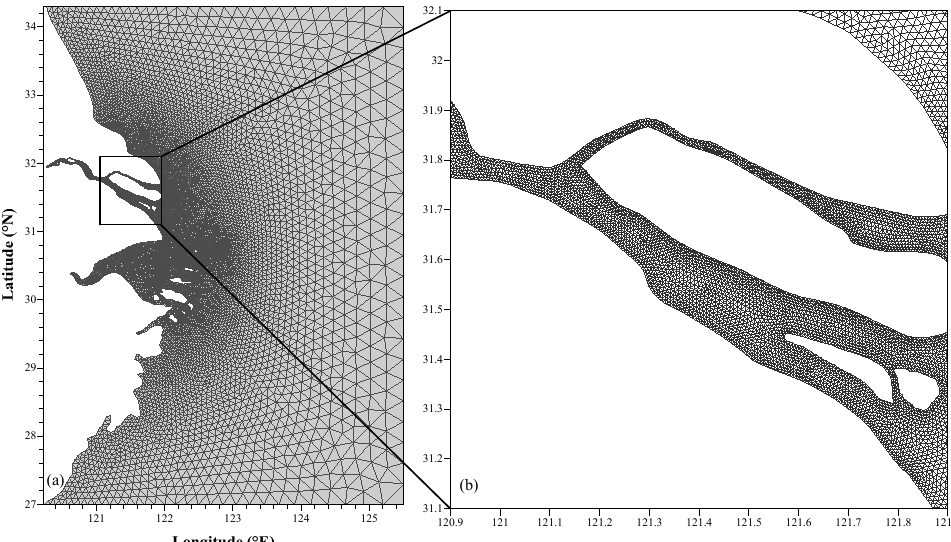
Figure 2. Study area and mesh. ( a ) the whole unstructured mesh of the model lies between a latitude of 26.9° and 34.4° N and a longitude of 120.2° to 125.6° E; ( b ) the finer mesh in the South Branch (SB) of Yangtze River.